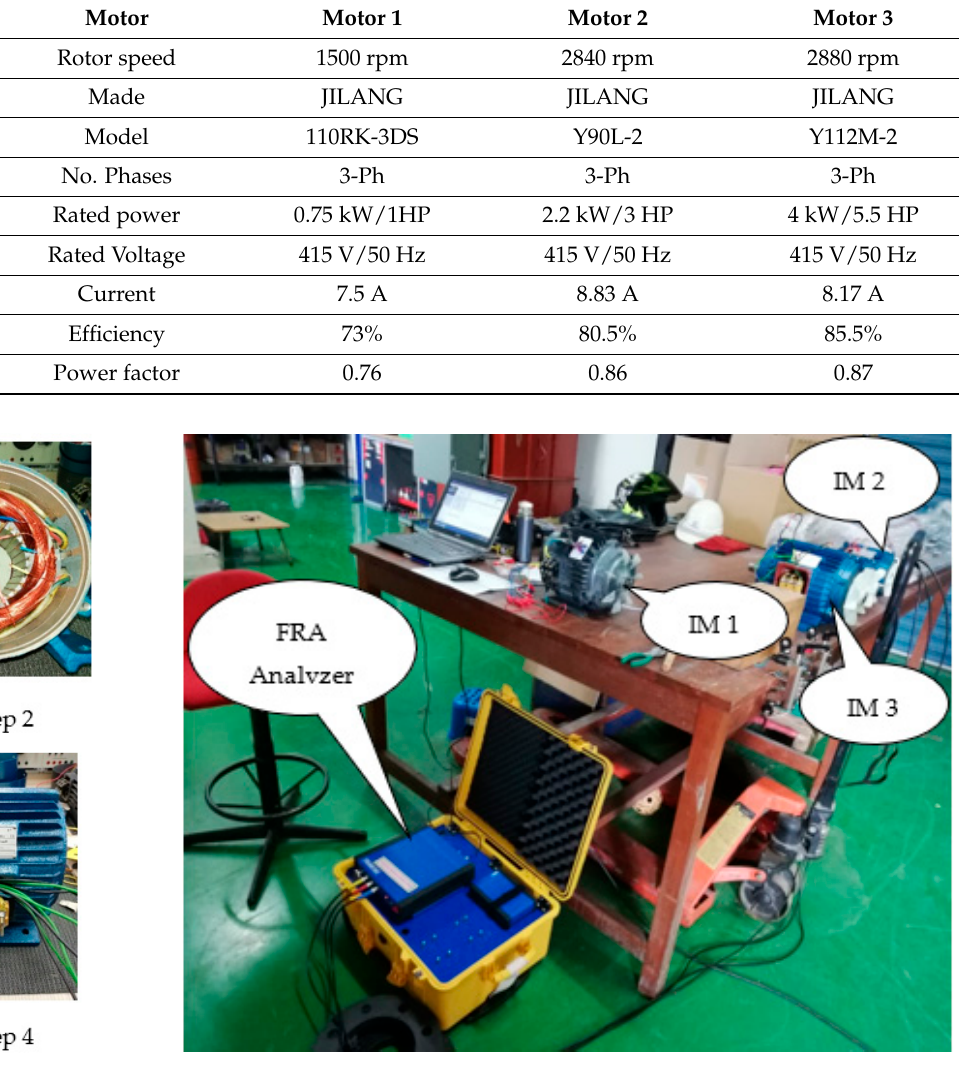
Table 1. Specifications data of the three IMs selected for the FRA laboratory measurements.